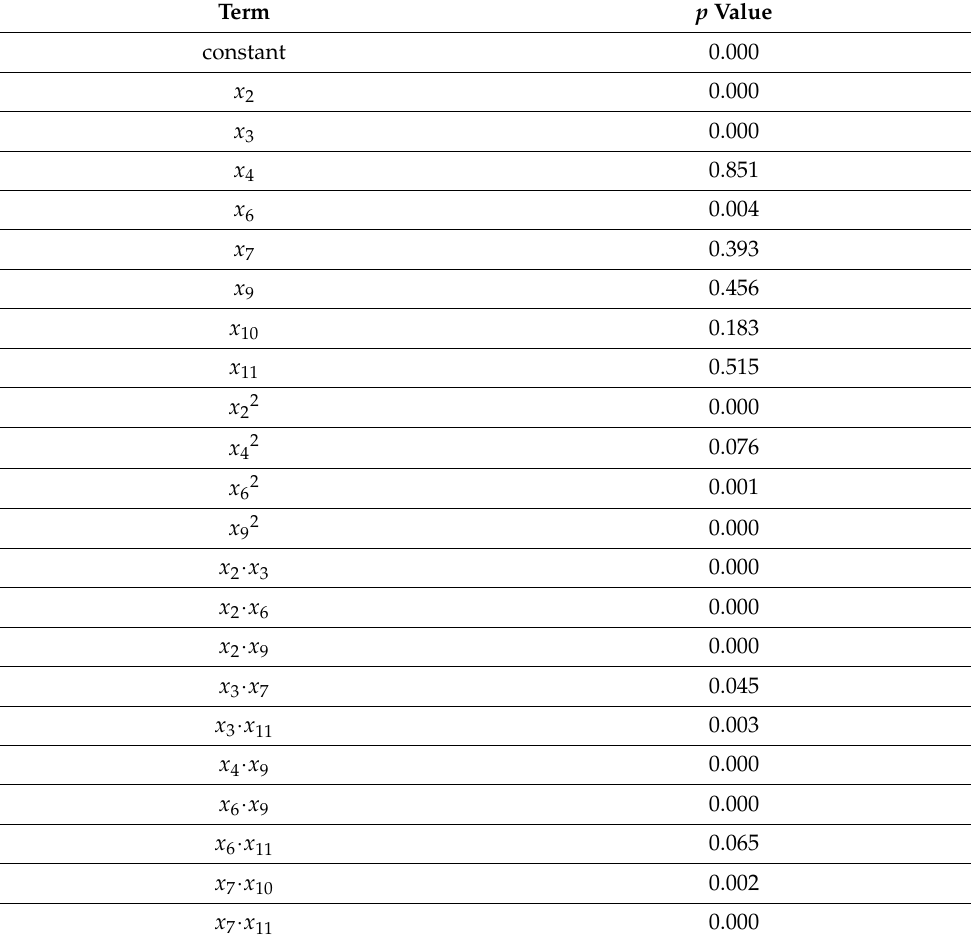
Table 8. ANOVA of tensile shear strength prediction model.